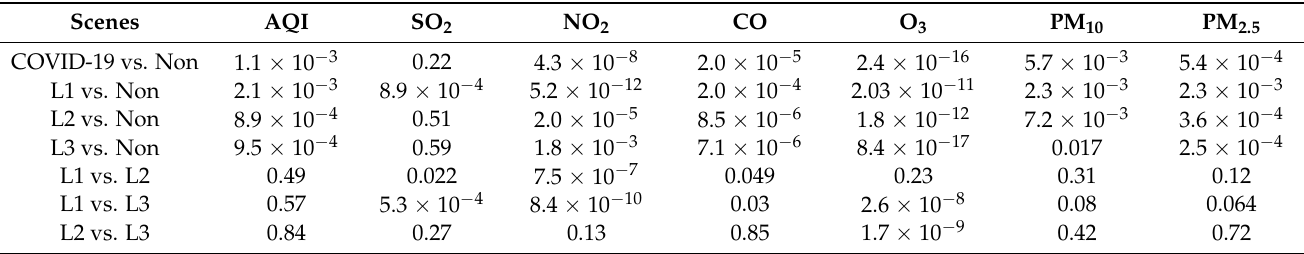
Table 2. Significance levels for periods with different levels of PPC measures by Student’s t-test ( α = 0.05).